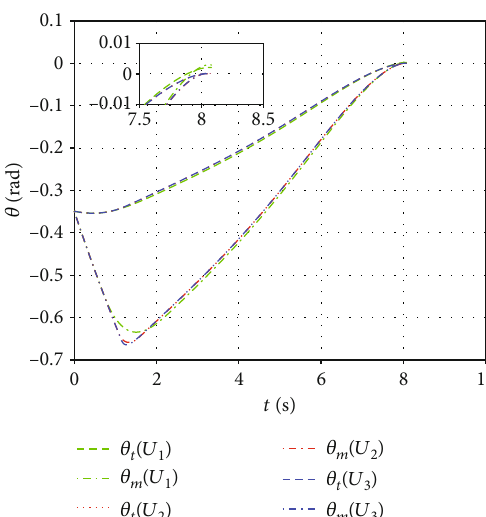
Figure 26: Direction angles φ .